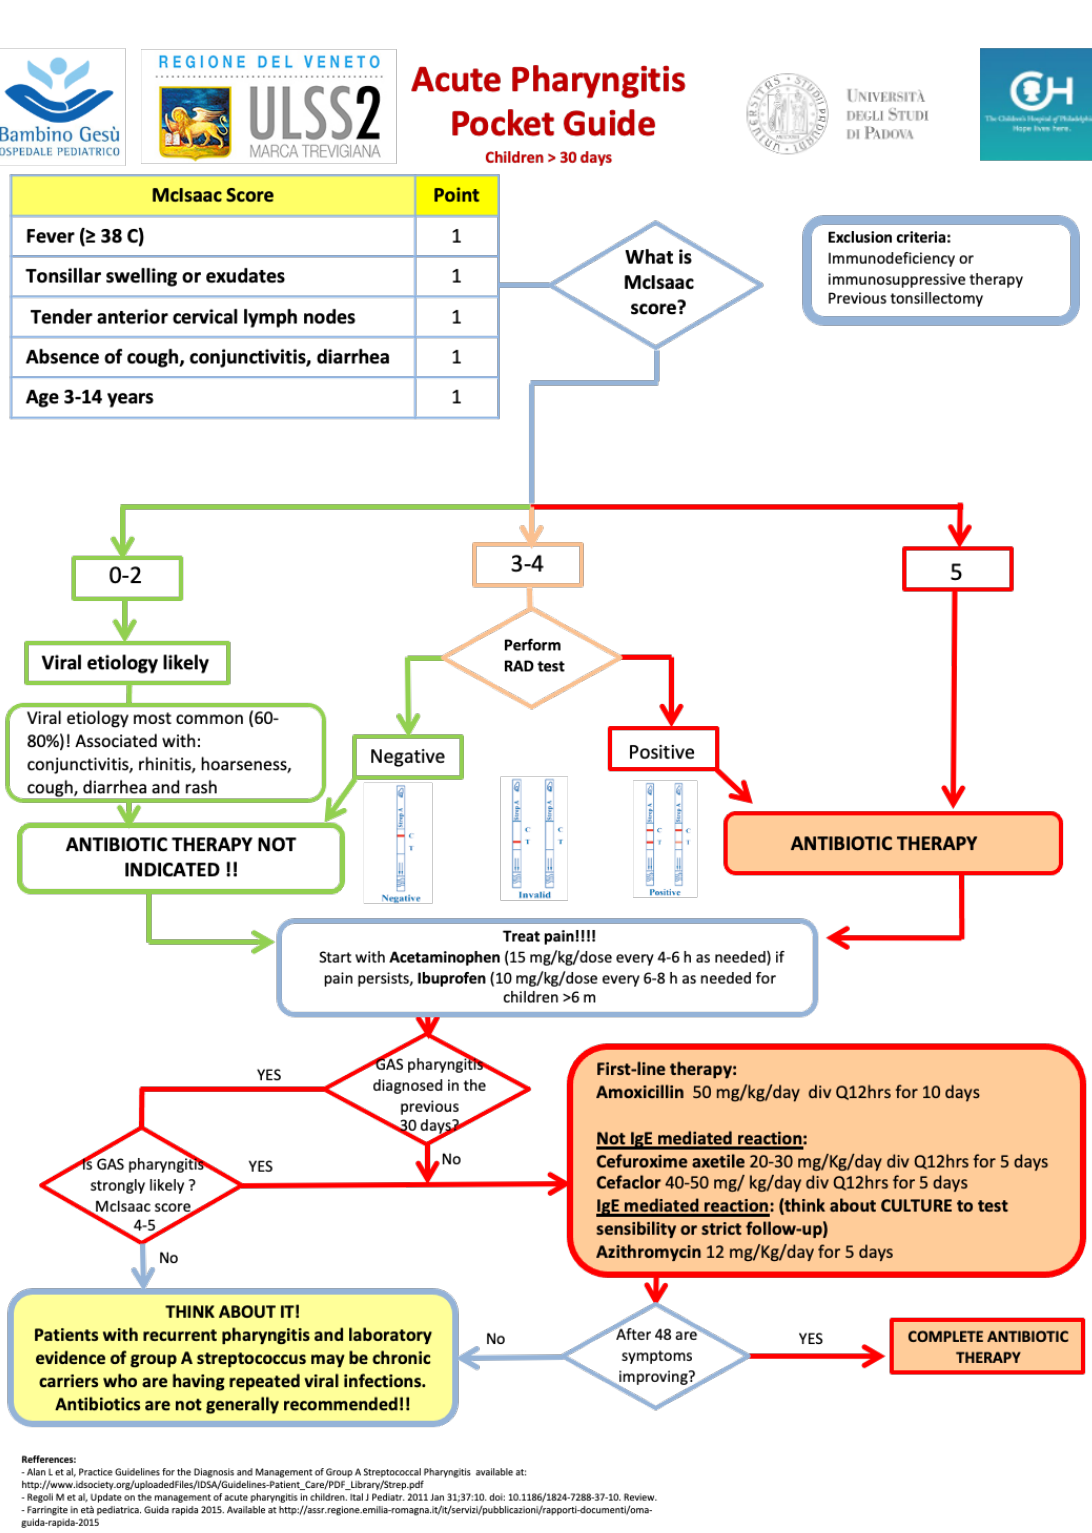
Figure A2. Clinical pathway for acute pharyngitis for children older than 30 days of age.